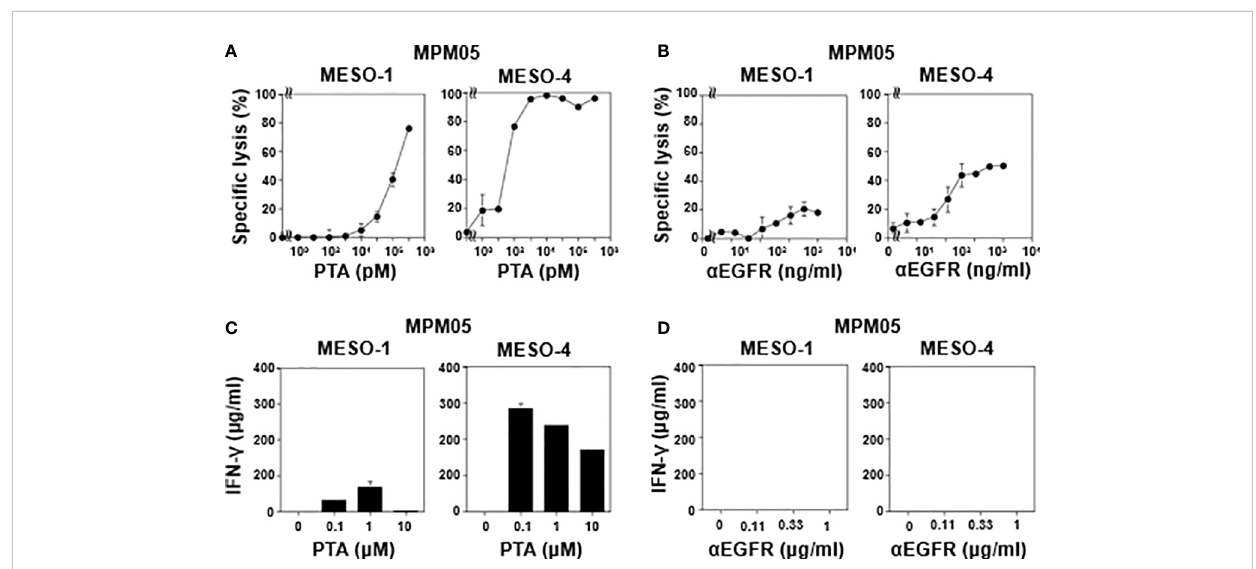
FIGURE 5 Effector functions of gd T cells-derived from MPM05. (A) Effect of PTA on cytotoxic activity of MPM05-derived gd T cells. MPM cells were challenged by gd T cells derived from an MPM patient and speci fi c lysis (%) were determined through luciferase assay. (B) Effect of anti-EFGR on cytotoxic activity of gd T cells. MPM cells were incubated with gd T cells derived from MPM05 and speci fi c lysis (%) were determined through luciferase assay. (C) Effect of PTA on IFN- g secretion from MPM05-derived gd T cells. MPM cells were treated with gd T cells derived from an MPM patient in the presence of a serial dilution of PTA and the supernatants were examined for IFN- g . (D) Effect of anti-EFGR on the production of IFN- g from gd T cells. MPM cells were challenged by gd T cells derived from MPM05 and the supernatants were examined for IFN- g